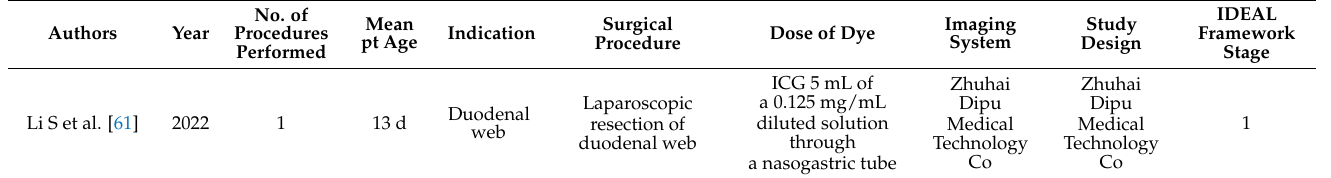
Table 7. The only case not belonging to any of the other